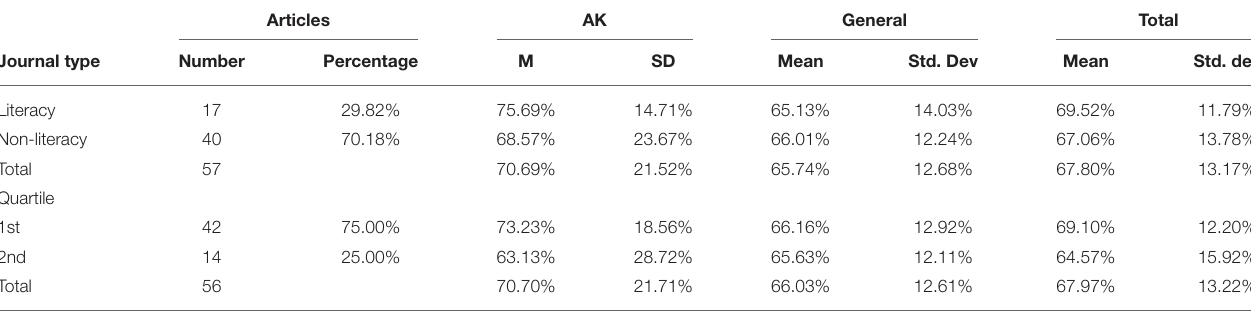
TABLE 3 | Averages and standard deviations for elements of reporting by type and quality of journal.